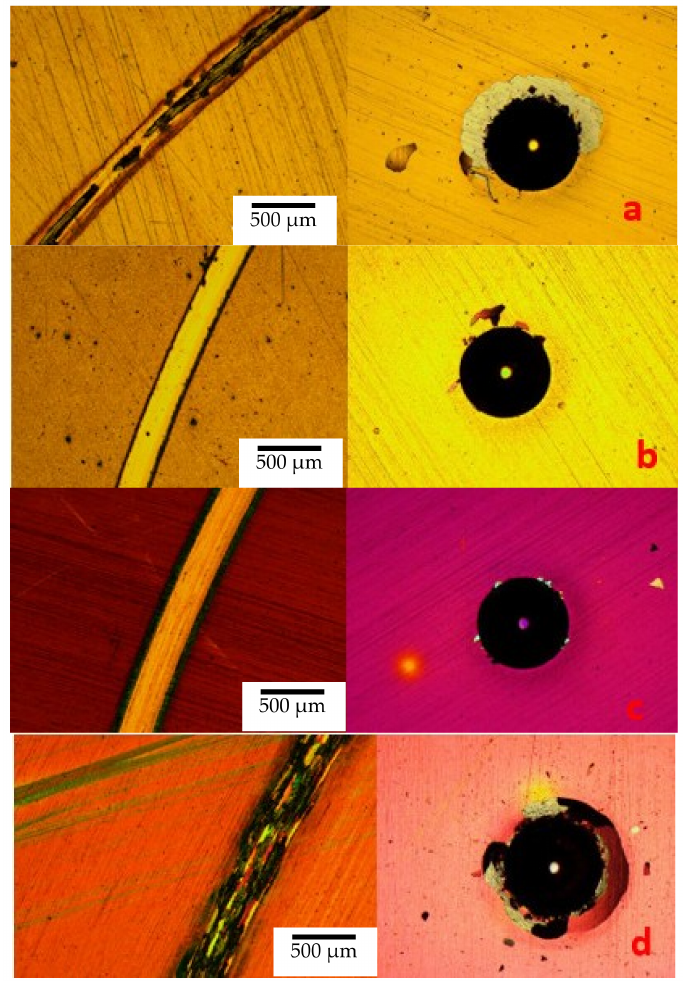
Figure 8. Wear tracks and Rockwell indentations of HiPIMS-TiN coating after testing at the temperatures: